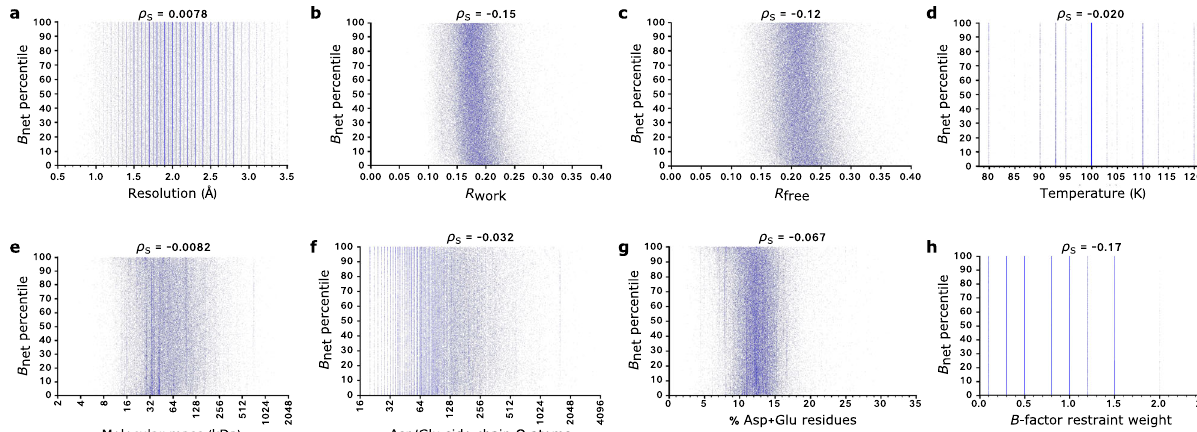
Fig. 5 Investigating the dependence of B net -percentile on various parameters. Scatter plots of B net -percentile vs.: a resolution; b R work ; c R free ; d temperature; e molecular mass; f the number of aspartate/glutamate side-chain oxygen atoms; g the percentage of aspartate/ glutamate residues; and h the strength of B -factor restraints applied in the fi nal round of re fi nement. The Spearman ’ s rank correlation coef fi cient ( ρ S ) between the two variables is reported for each plot. Source data are provided at https://doi.org/10.5281/zenodo.5566558.